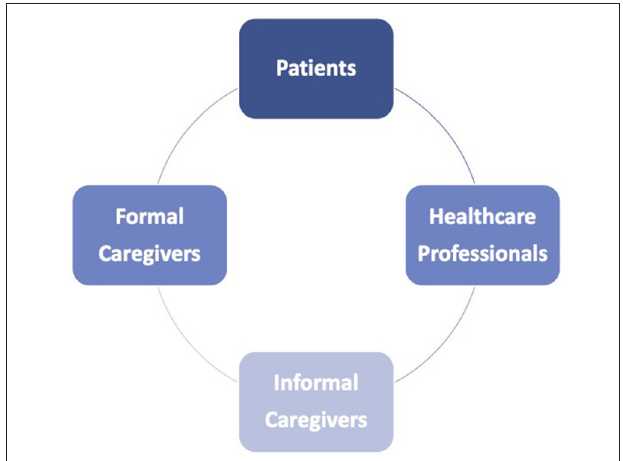
FIGURE 1 | Relationships between patients, professional and non-professional stakeholders in telemedicine health care provision.